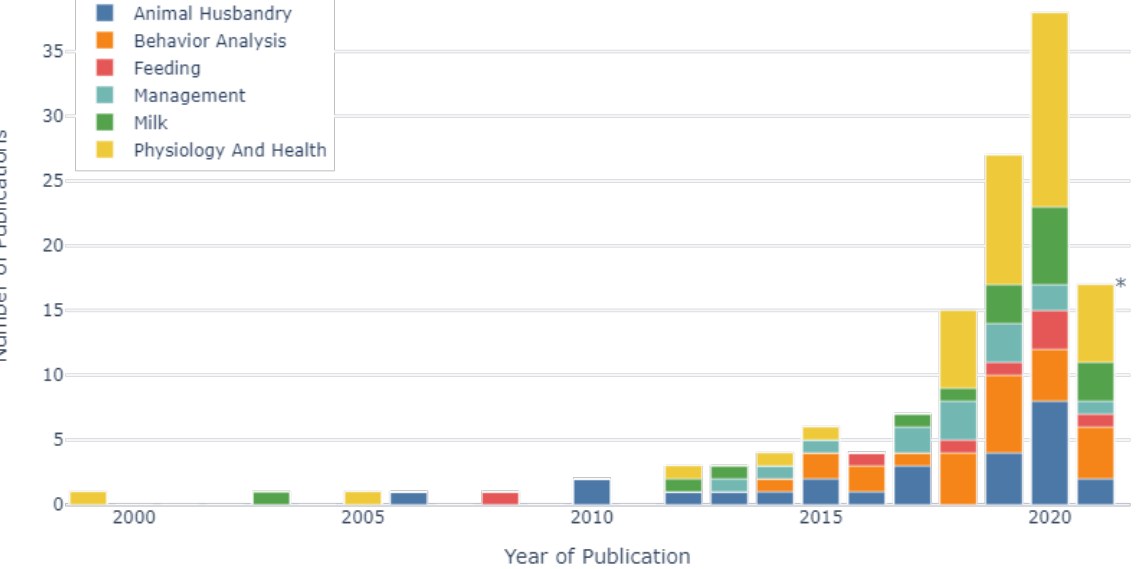
Figure 4. Number of publications per year labelled according to research category (n = 131). * Data collected up to June 2021.